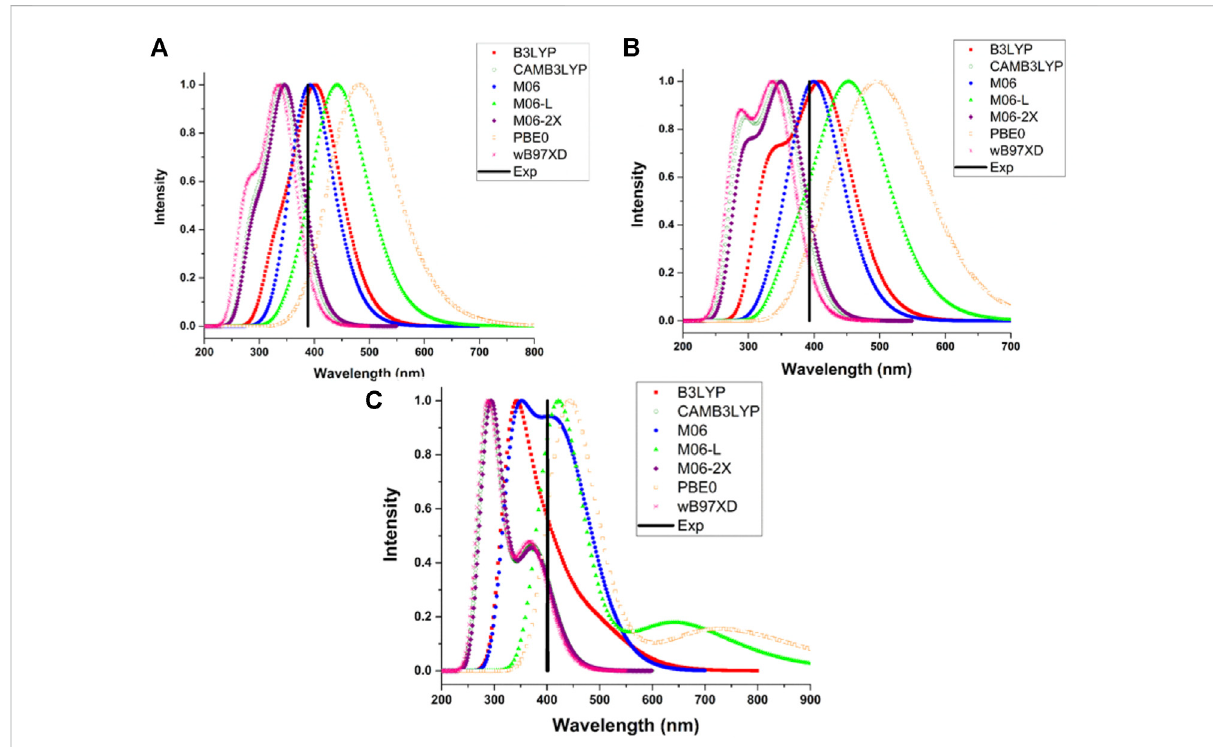
FIGURE 4 Comparison oftheexperimentalmaximumabsorption wavelengthwiththecalculatedabsorptionspectrafor the (A) 1TPAM, (B) 2TPAMand (C) 3TPAM, obtained with several